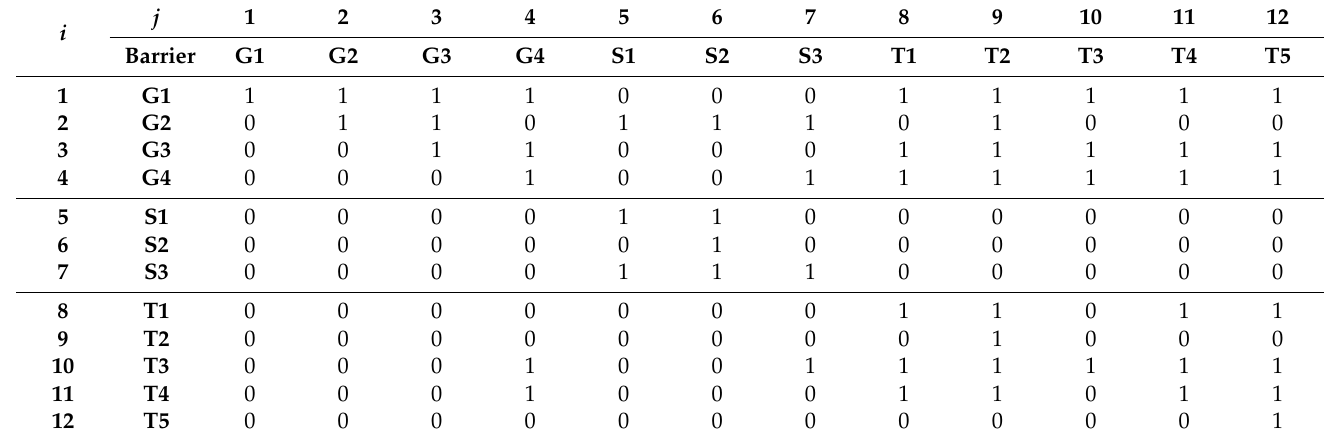
Table A2. Initial Reachability Matrix (RM init ) (Conventional Method).